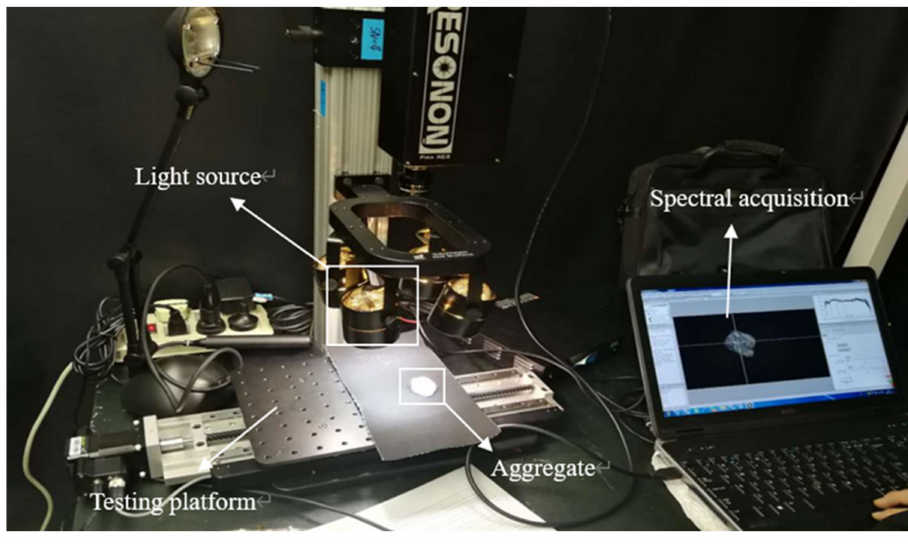
Figure 8. Hyperspectral test.